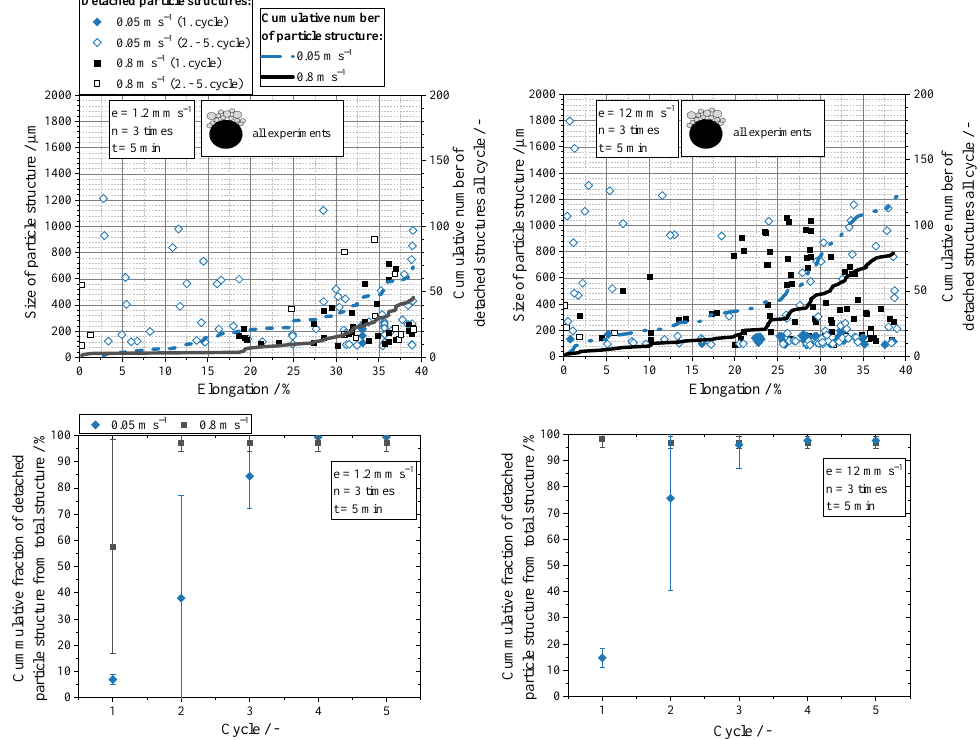
Figure 10. ( TOP ) Size and cumulative number of detached particle structures measured with the LSDS during the 5 cycles of fiber stretching. Comparing two different elongation velocities (1.2mm s − 1 , left; 12mm s − 1 , right) for two different superficial velocities during the stretching procedure (0.8m s − 1 and 0.05m s − 1 , respectively). ( BOTTOM ) Cumulative fraction of the detached particle structures from total particle